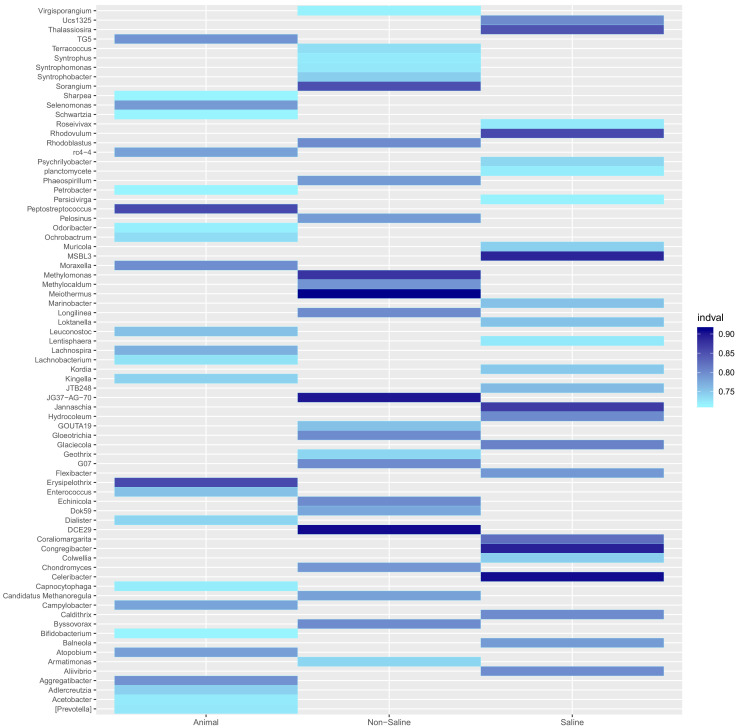
Resident genera of environment clusters.Results from indicator species analysis illustrated as a heatmap. Only the 25 resident genera with the highest indval indices and p<0.05 (permutation test) are shown for every environment cluster (animal-associated, non-saline and saline free). For the full results see Supplementary file 5.